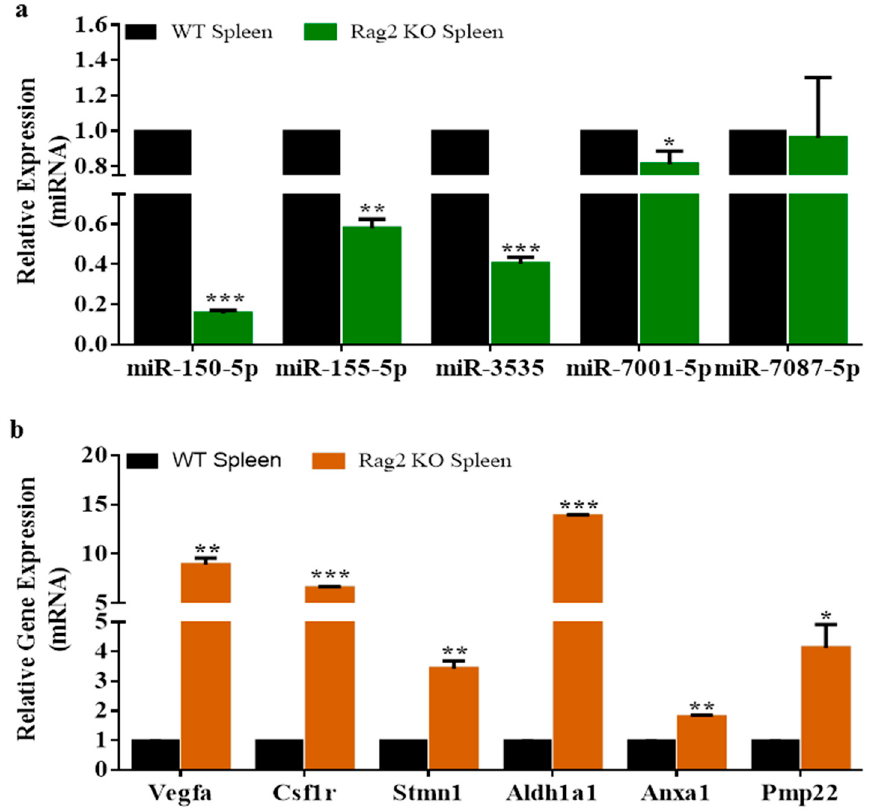
Figure 6. Validation of the deregulated miRNAs and genes expression in Rag2 KO mice. ( a ) Validation of the downregulated expression of miR-150-5p, miR-155-5p, miR-3535, miR-7001 and miR-7087-5p in Rag2 KO mice; ( b ) Validation of the upregulated expression of the corresponding targets ( Vegfa , Csf1r , Stmn1 , Aldh1a1 , Anxa1 and Pmp22 ) of the downregulated miRNAs in Rag2 KO mice. *** p < 0.001, ** p < 0.01 and * p < 0.05.